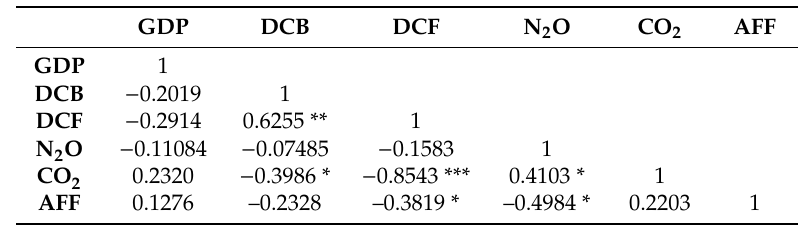
Table 2. Correlation matrix for the variables of